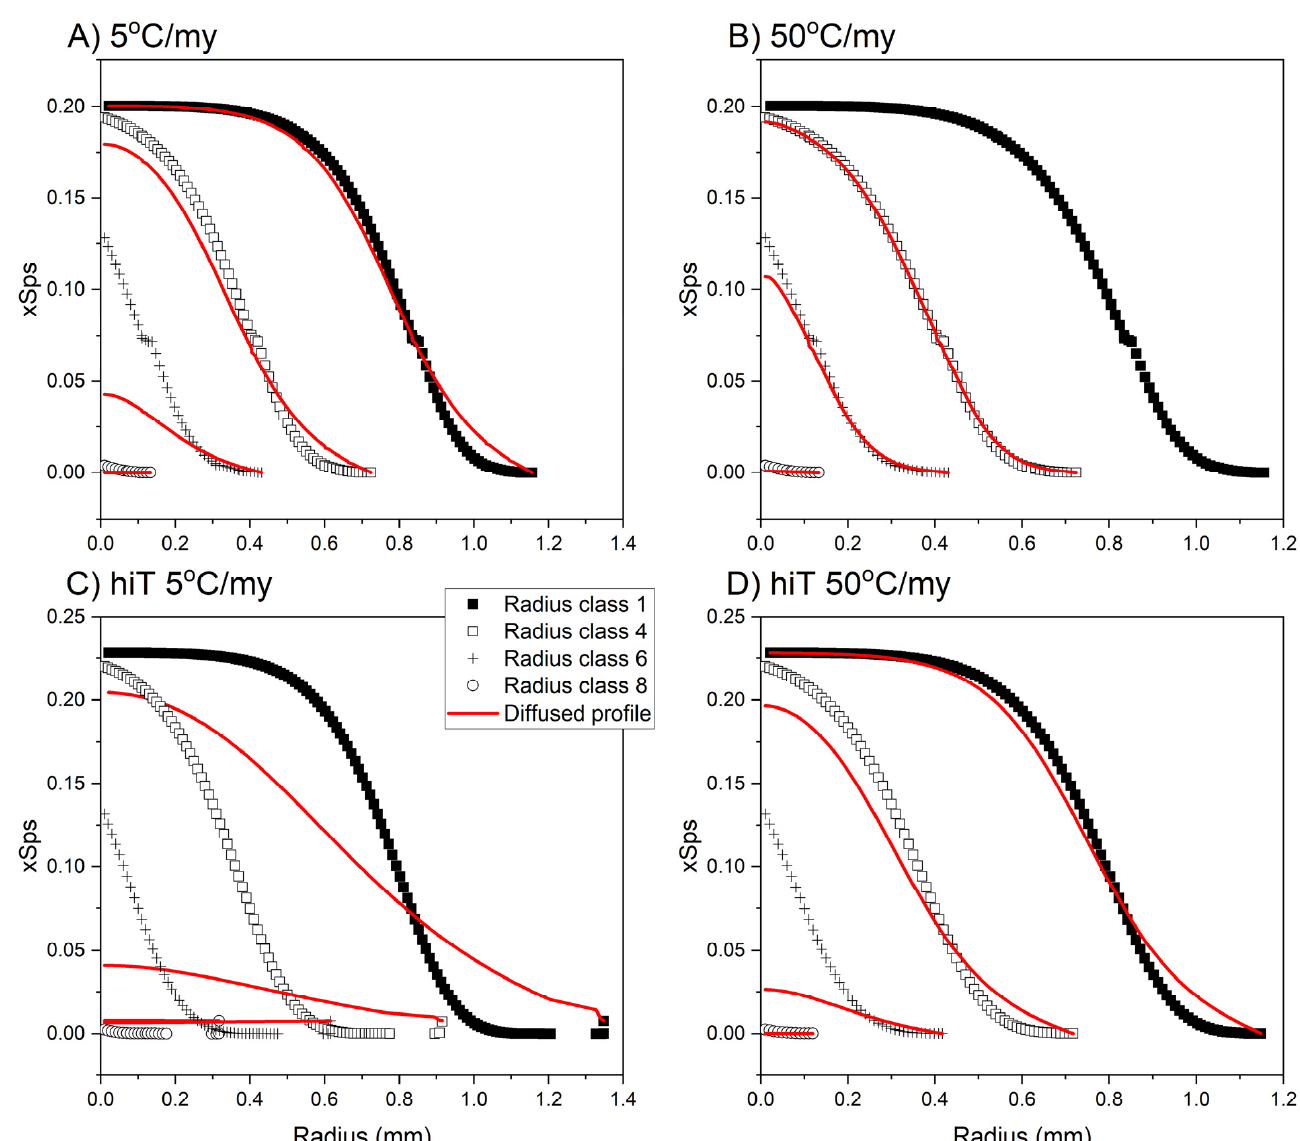
Figure 6. Compilation of the THERIA_G modeled spessartine mole fractions for radii classes 1, 4, 6, and 8. Radius is the distance in mm from the core. Symbols represent model-predicted initial prograde growth profiles and are not impacted by intracrystalline diffusion, whereas the solid red lines correspond to the final diffusion-impacted profiles. Each panel is a separate simulation unique in heating/cooling rate and/or input P-T path. ( A ) Results from a simulation evolved along [26] path “B” at a heating/cooling rate of 5 °C/my. ( B ) evolved along [26] path “B” at a heating/cooling rate of 50 °C/my. ( C ) evolved along the hiT path (Figure 3B) with a heating/cooling rate of 5 °C/my. ( D ) evolved along the hiT path with a heating/cooling rate of 50 °C/my. All data are plotted at the same y-scale for ease of comparison.